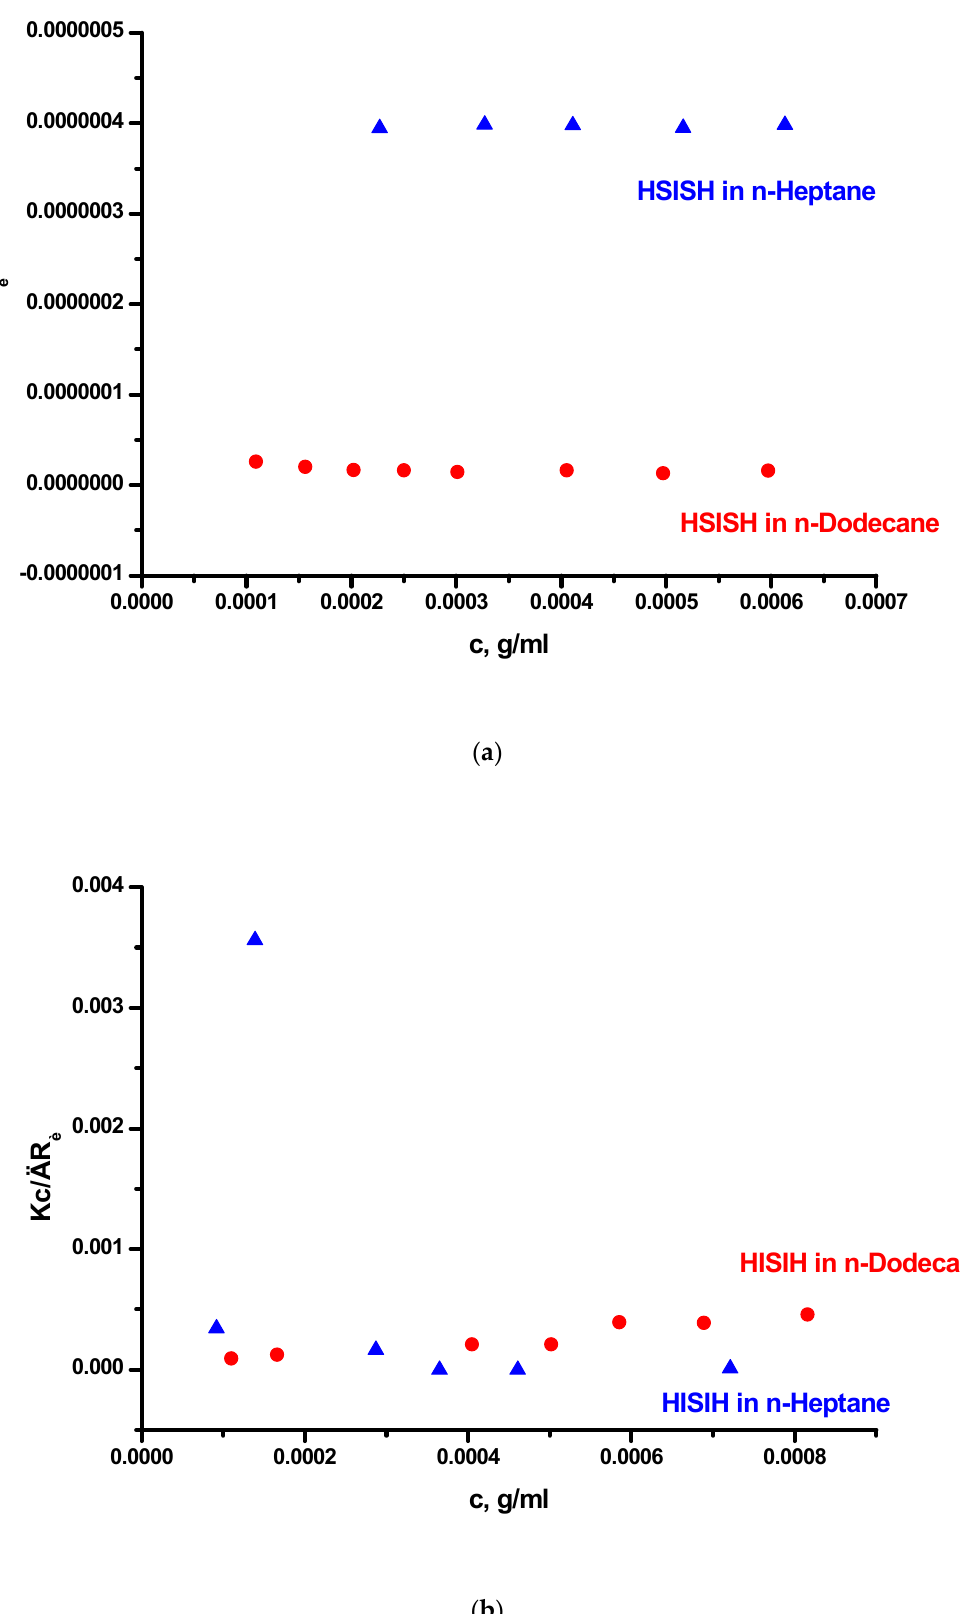
Figure 3. ( a ) LALLS plots of the HSISH pentablock terpolymer in n-heptane and n-dodecane and ( b ) LALLS plots of the HISIH pentablock terpolymer in n-heptane and n-dodecane .